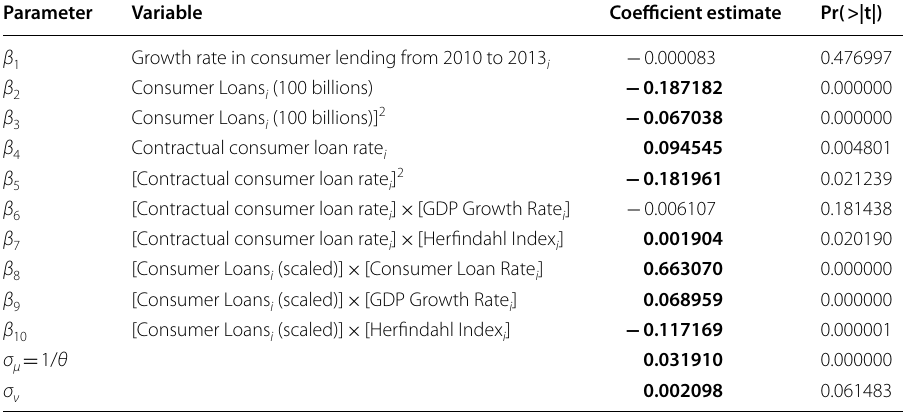
The data set includes LendingClub and 654 top-tier bank holding companies at the end of 2013 with plausible values of nonperforming unsecured consumer loans and total loans exceeding 10 percent of assets Skewness and D’Agostino skewness test of OLS residuals ( ∼ N ( 0,1 ) asymptotically ) : skewness = 4.3632 (> 0 ) ⇒ positively skewed test statistic = 20.7152 with p -value < 2.2E 16 ⇒ positively skewed with statistical significance. − Histogram and density of OLS residuals in the relative frequency scale appear in Appendix 2